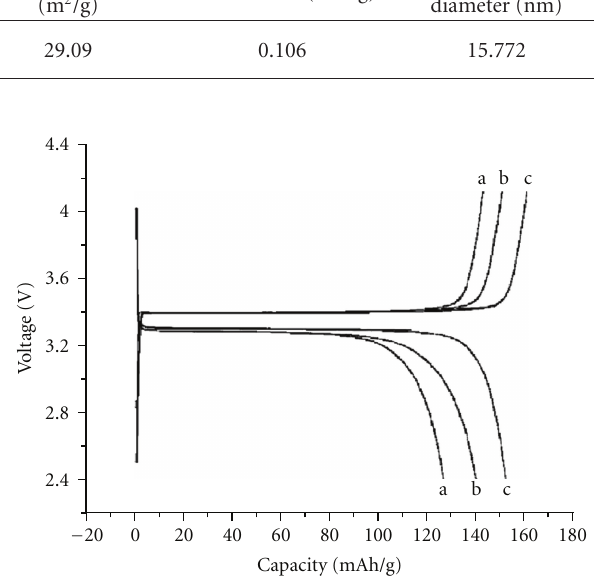
Figure 5: Charge/discharge curves of LiFePO 4 /CNT electrode, at di ff erent rates; (a) 2C, (b) 1C, and (c) 0.1 C.